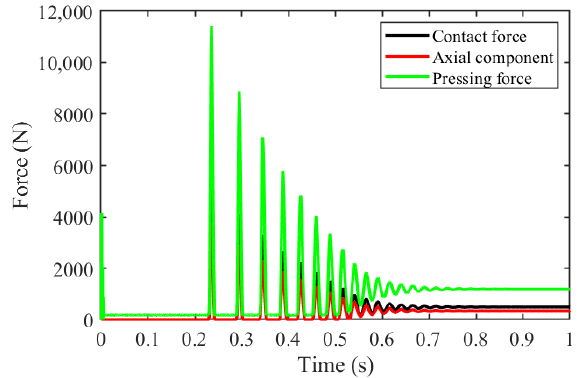
Figure 13. Dynamic features of ball ‐ and ‐ socket contact pair under forward load.